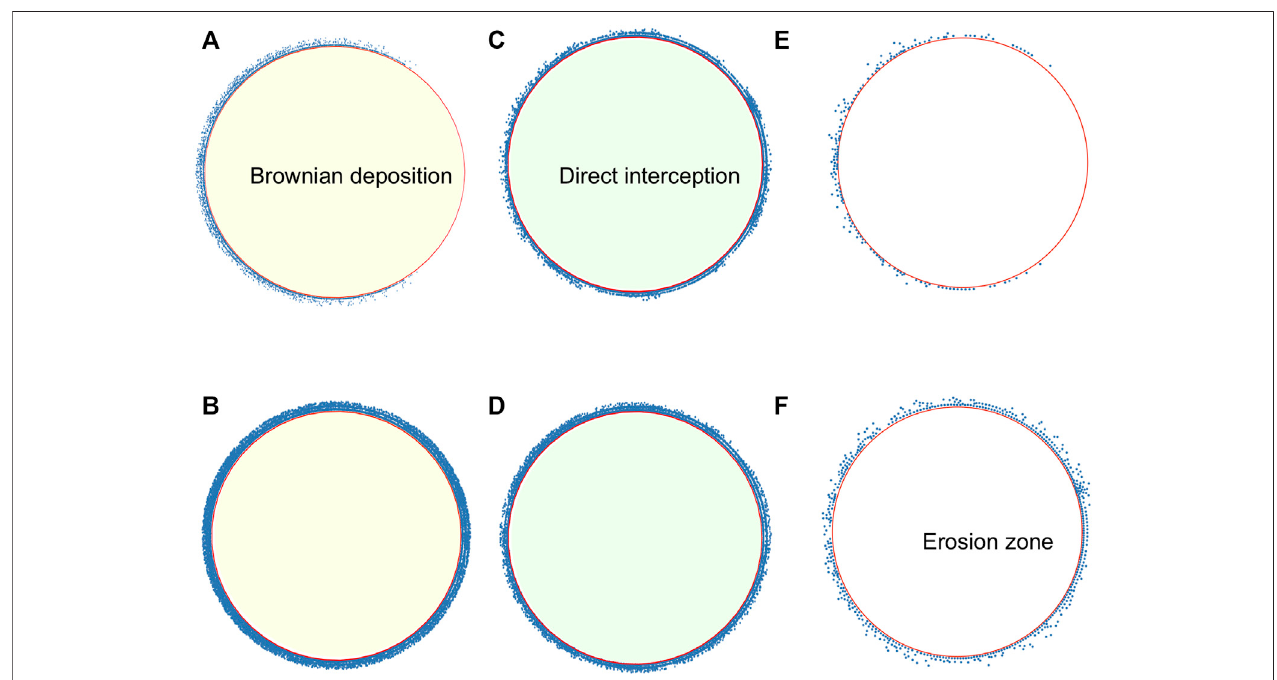
FIGURE 2 | Snapshots of microswimmers on the adhesion region at different regimes. Brownian deposition for more-persistent microswimmers for u 0 = 14, U ∞ = 40, R =100 (A) at t = τ trap (B) at t =200.Directinterceptionforless-persistentmicroswimmersfor u 0 =50, U ∞ =40, R =100 (C) at t = τ trap , (D) at t =200.Microswimmers, in the adhesion region, for u 0 = 20, U ∞ = 150, R = 100, (E) at t = τ trap (F) at t =